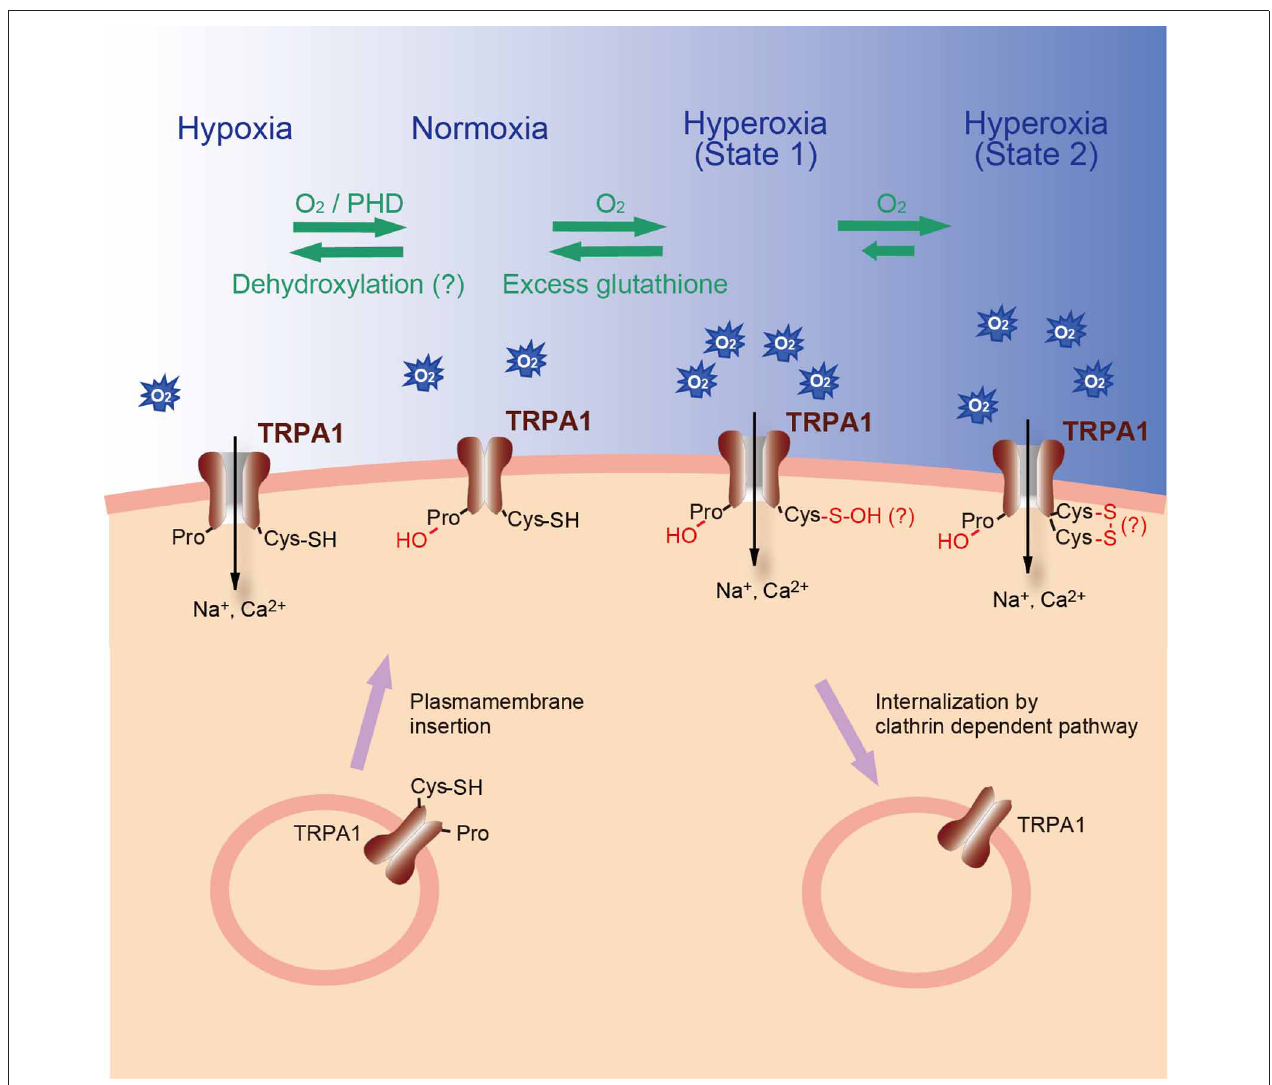
residues, thereby activating TRPA1. TRPA1 may at least take two oxidized state upon hyperoxia: a relatively unstable oxidized state (state 1) readily reversed by glutathione and a relatively stable oxidized state (state 2). Sulfhydryl group(s) of the key Cys residues may be modified to sulfenic acid in the former state of TRPA1, whereas that in the latter state of TRPA1 may form a disulfide bond(s). These oxidation mechanisms over-ride the inhibition by Pro hydroxylation to activate